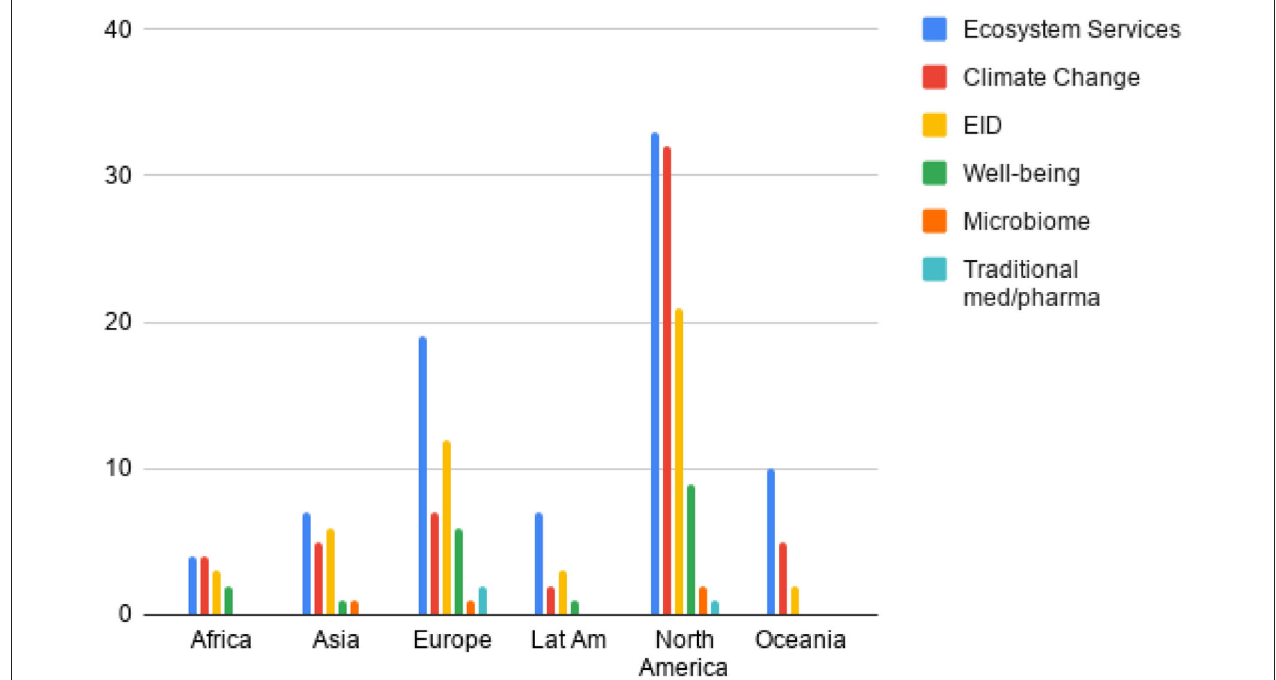
FIGURE 2 | Coverage of biodiversity and health interlinkages throughout offerings by region (LatAm, Latin America and the Caribbean; EID, Emerging Infectious Diseases).